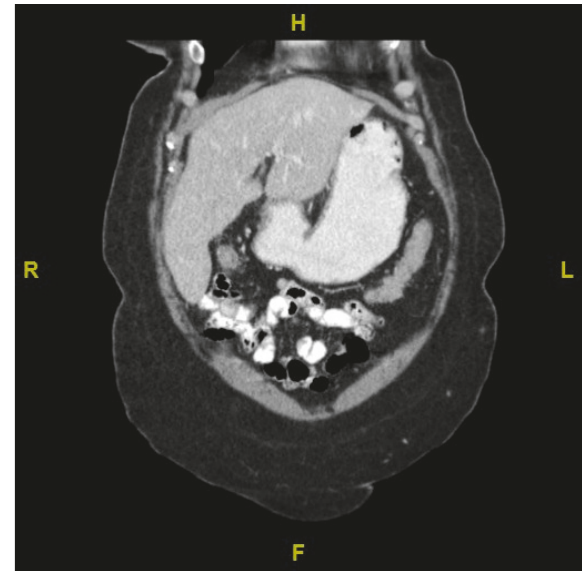
Figure 3: Follow-up CT sagittal view of abdomen at 7 weeks indicates marked improvement.